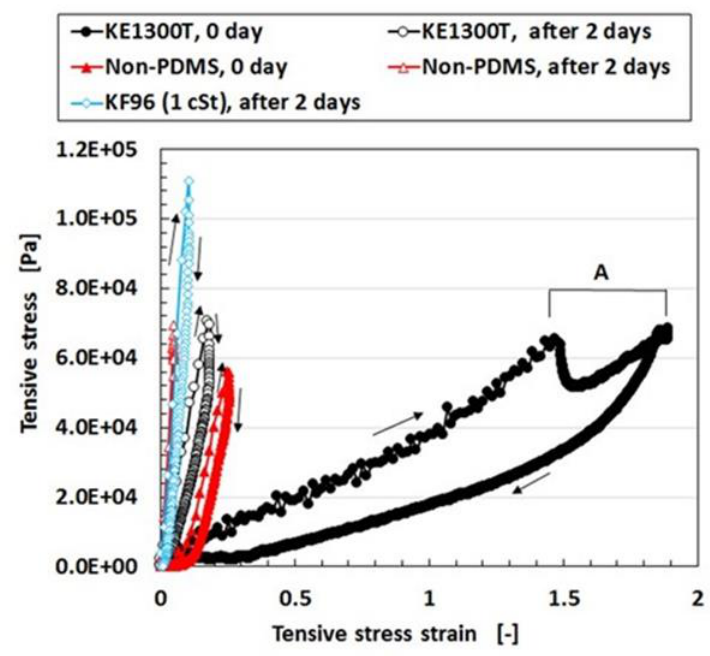
Figure 4. Relation between stress strain and stress in tension; as for KE1300T, 3 g KE1300T + 3 g PVA; as for Non-PDMS, without KE1300T or KF96 + 3 g, and PVA; as for KF96, 3 g KF96 + 3 g PVA; all has 3